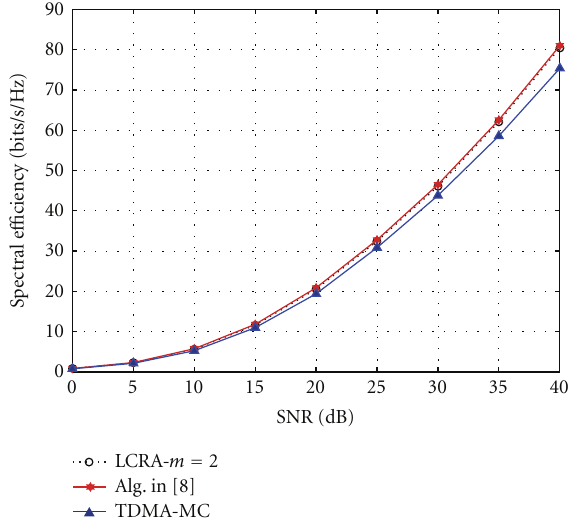
Figure 7: Spectral e ffi ciency versus number of MGs.